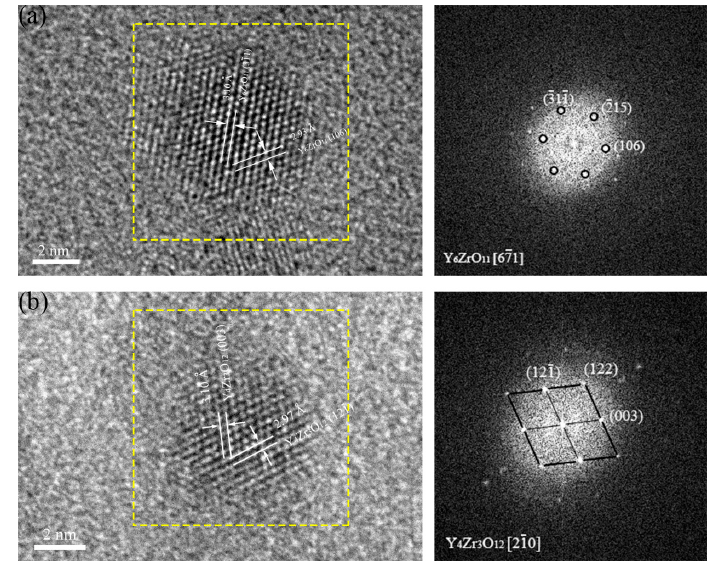
Figure 7. HRTEM micrographs and corresponding FFT images of oxide nanoparticles in: ( a ) 16Cr-0.3Zr ODS steel; and ( b ) 16Cr-0.6Zr ODS steel.